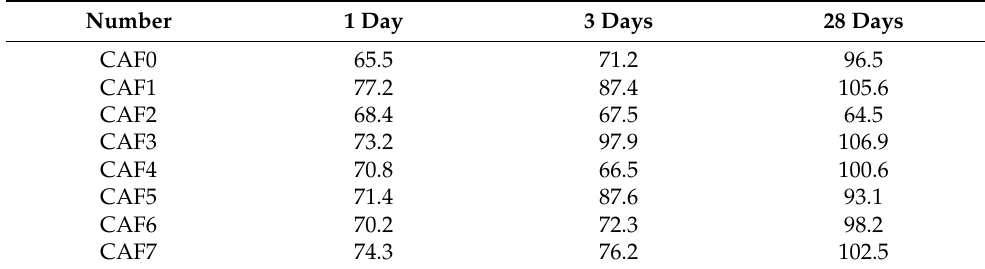
Table 2. Compressive strength of clinkers